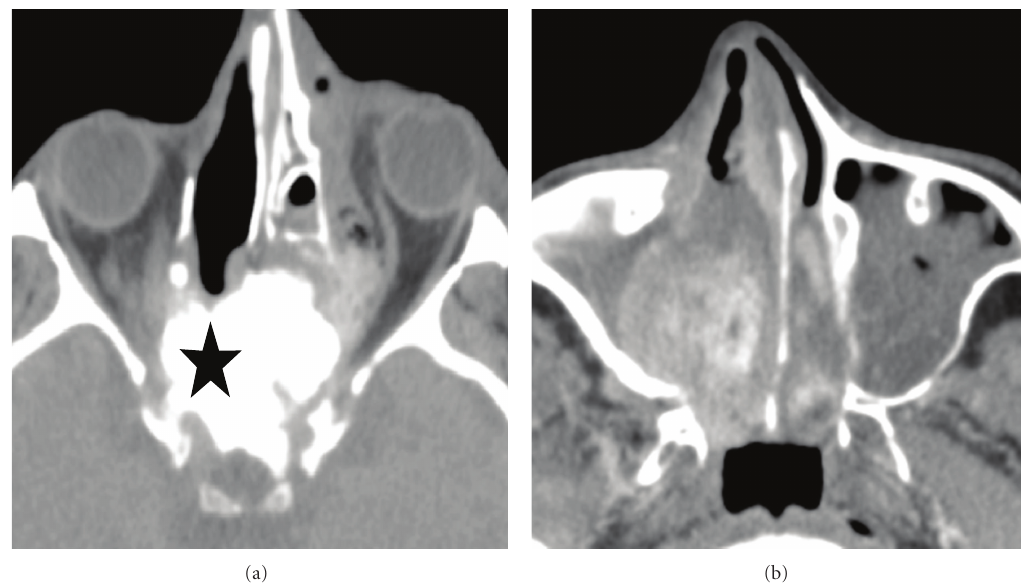
Figure 1: (a) Initial facial axial CT scan showing a mixed iso- and hyperdense mass (black star) of the right lateral nasal wall extending to the left orbit, (b) facial axial CT scan one month later showing progression of the tumor to involve the right maxillary sinus, the nasal fossa.